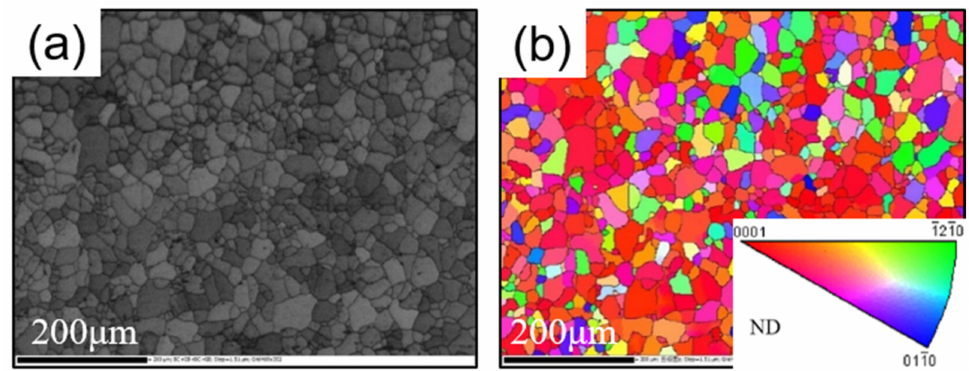
Figure 2. EBSD data of incoming sheet material. ( a ) contrast map and ( b ) grain orientation